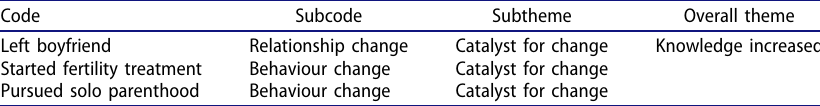
Table 1. Sample analytic